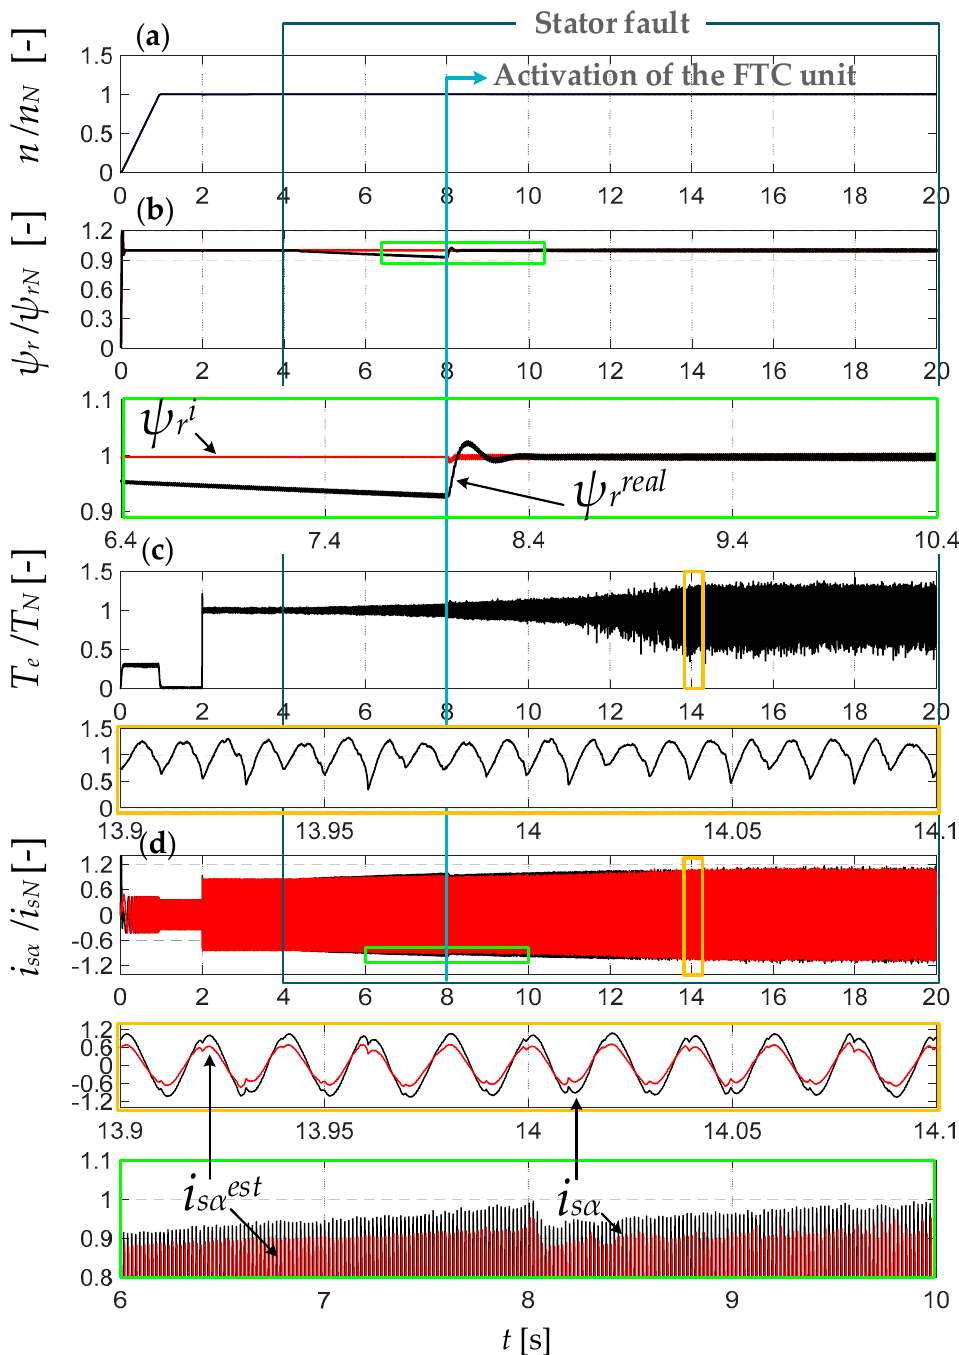
Figure 11. Operation of closed-loop control scheme (DFOC) during ITSC with the modified current model (MCM) in the control structure: ( a ) reference and real rotor speed, ( b ) estimated and real rotor flux, ( c ) electromagnetic torque, ( d ) estimated and real stator current in phase A; (simulation results), ( n ref = n N , T l = T N ).